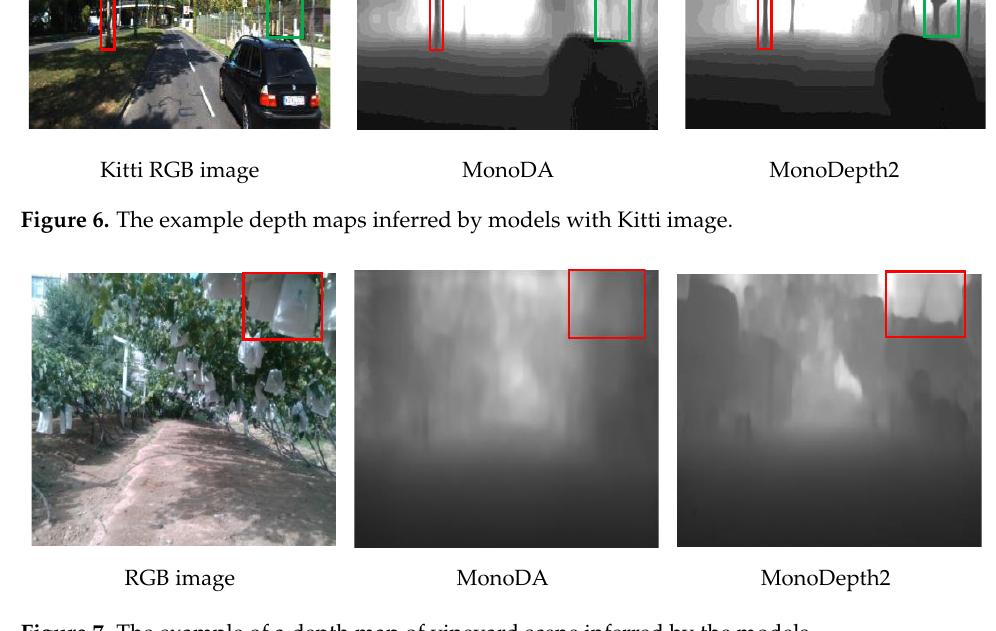
Figure 7. The example of a depth map of vineyard scene inferred by the models. According to the actual distance test results shown in Table 4, the Average Relative